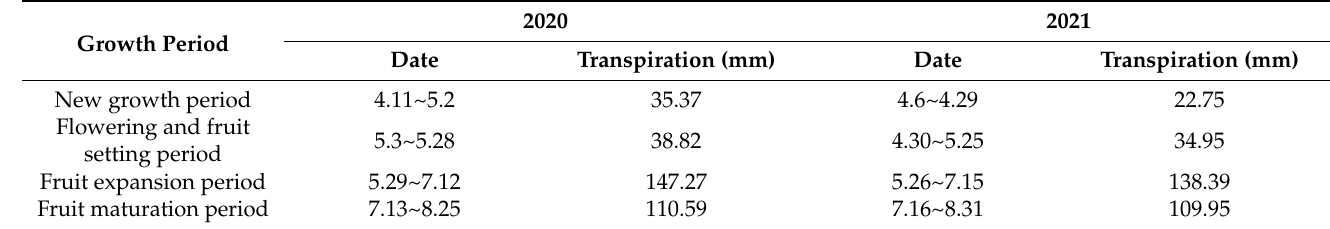
Table 1. Growth period division and transpiration in 2020 and